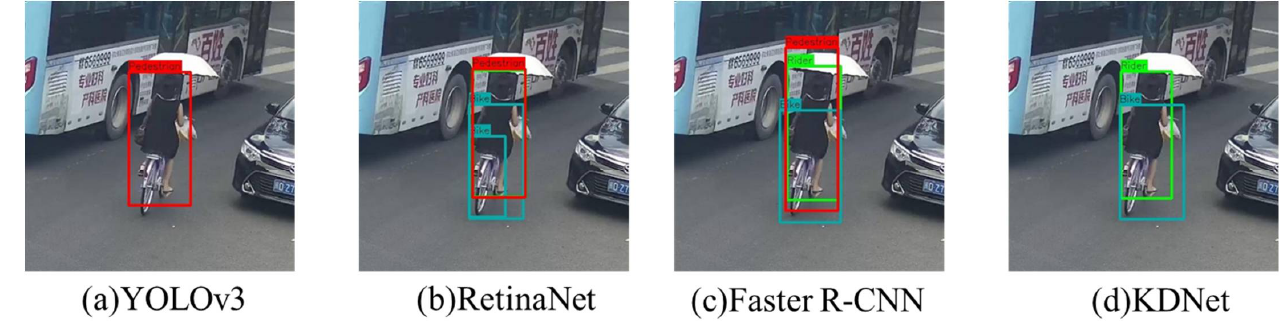
Figure 6. The detection results of the position of Rider and Bike .